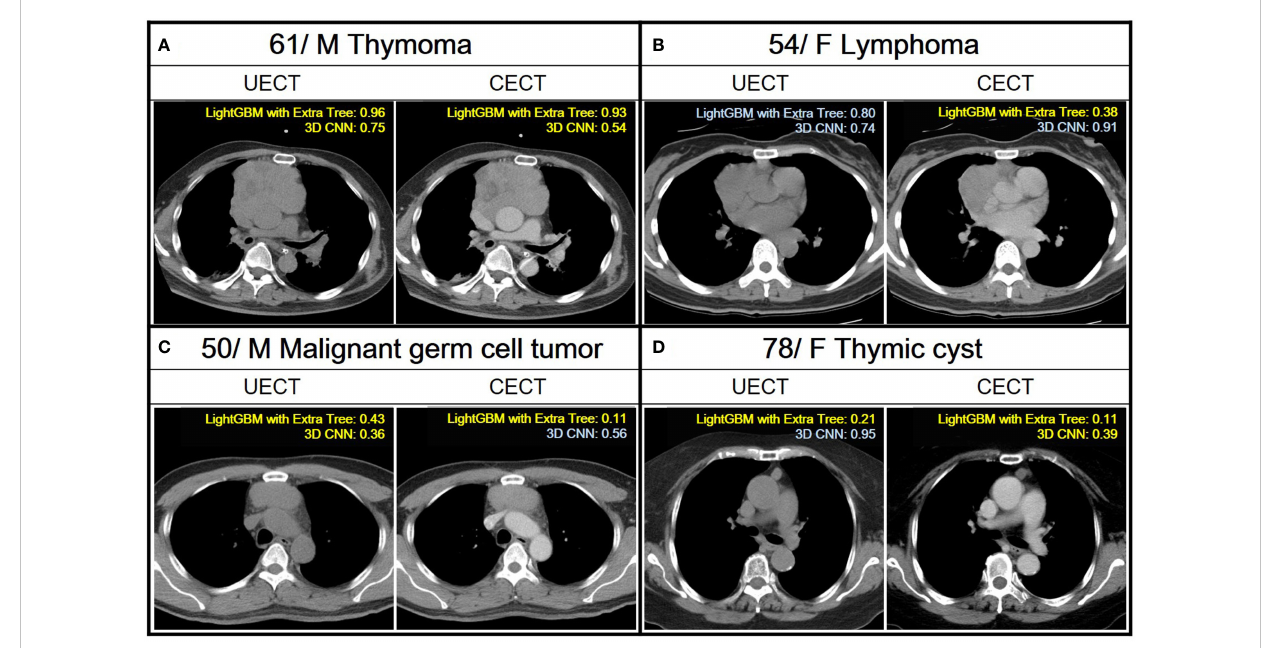
FIGURE 4 Demonstration of the application of ML and 3D CNN classi fi cation models to analyze four distinct cases with varying pathologies. A case is classi fi ed as TET if the con fi dence score obtained from a ML model and 3D CNN using their UECT and CECT, respectively, is greater than 0.50, and classi fi ed as non-TET if it is less than or equal to 0.50. Yellow text indicates correct predictions, while blue text indicates incorrect predictions. (A) A 61 years old male with thymoma. Both LightGBM with Extra Tree and 3D CNN had correct prediction from UECT and CECT. (B) A 54 years old female with lymphoma. The LightGBM with ExtraTree had correct prediction from CECT. (C) A 50 years old male with malignant germ cell tumor. The LightGBM with Extra Tree had correct prediction from both UECT and CECT, while 3D CNN had correct prediction from UECT. (D) A 78 years old female with thymic cyst. The LightGBM with Extra Tree had correct prediction from both UECT and CECT, while 3D CNN had correct prediction from